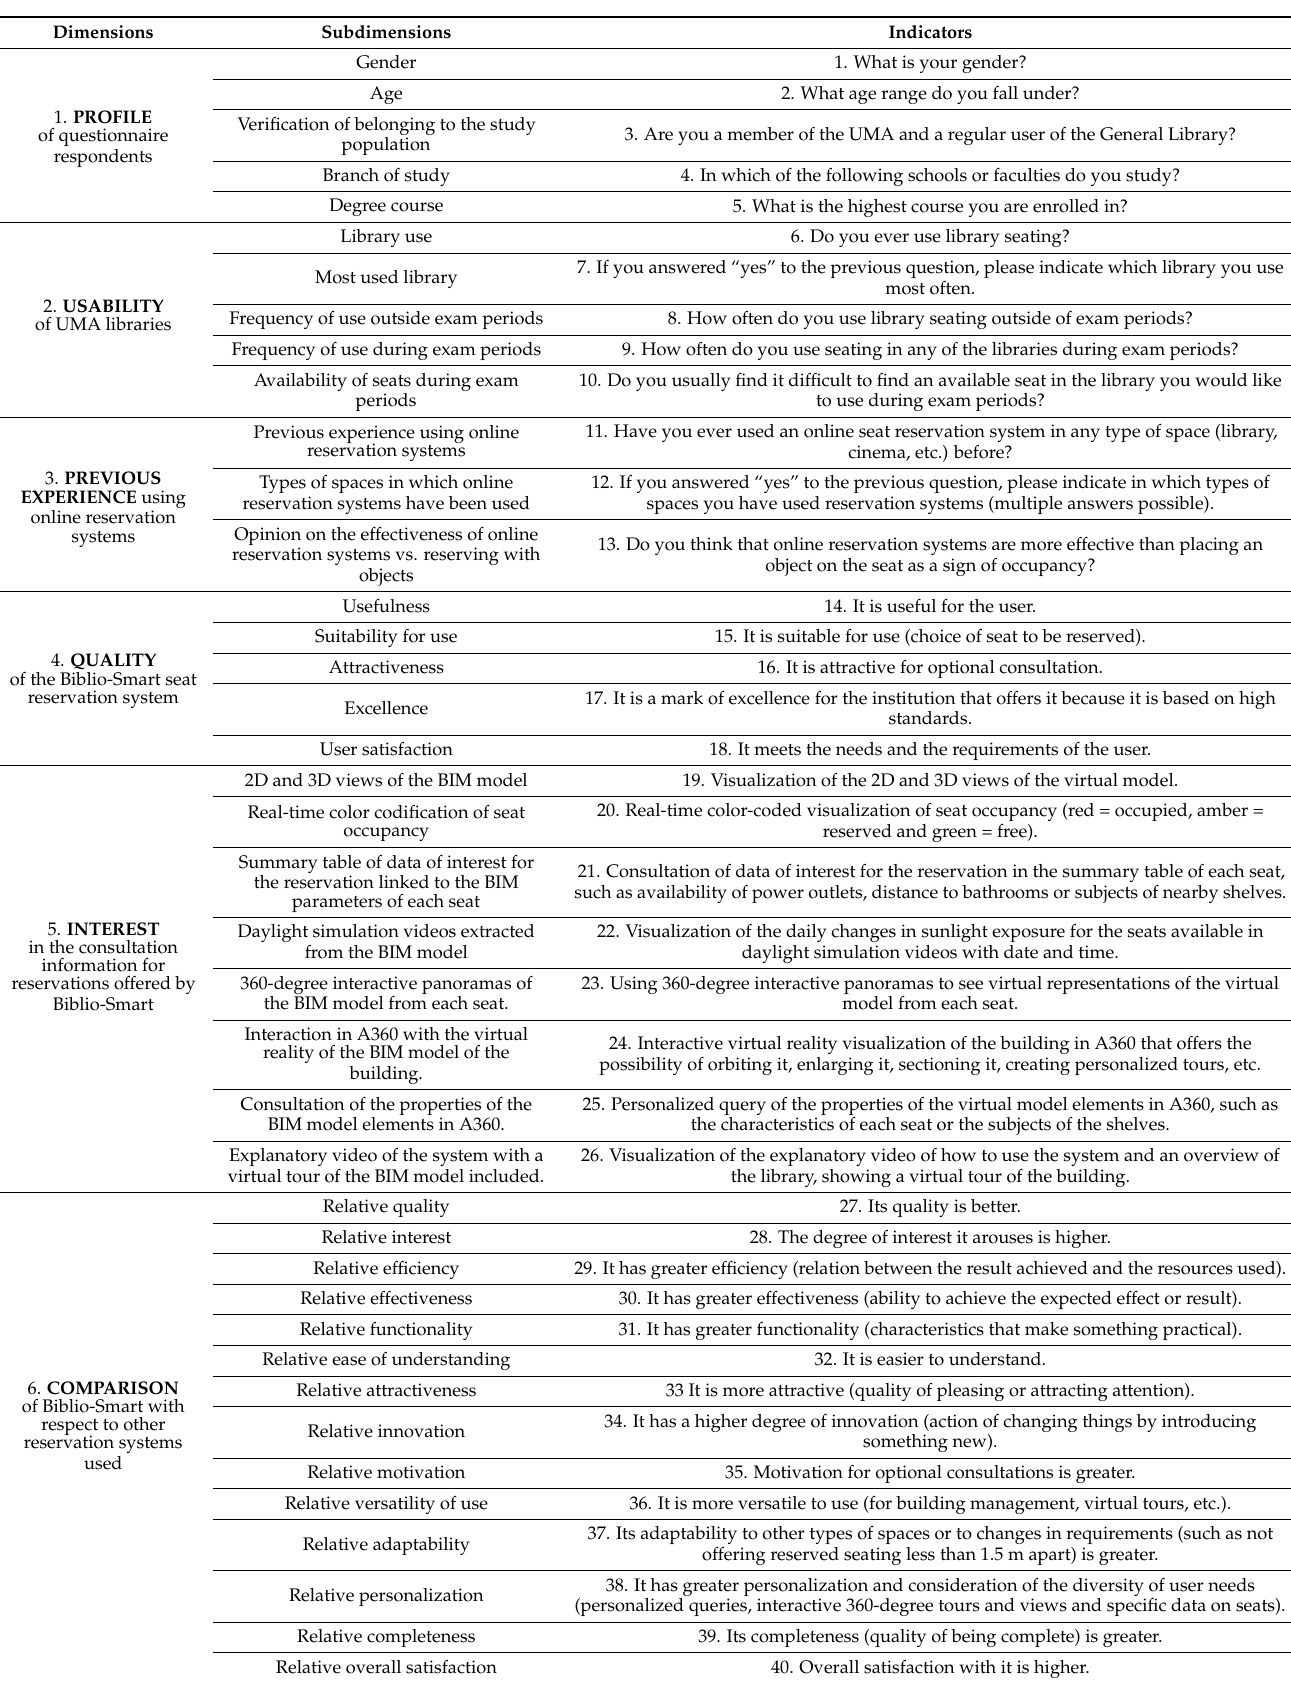
Table 2. Proposed operationalization of the concept “Evaluation of the Biblio-Smart system for seat reservation according to members of the UMA, regular users of the library where the prototype was